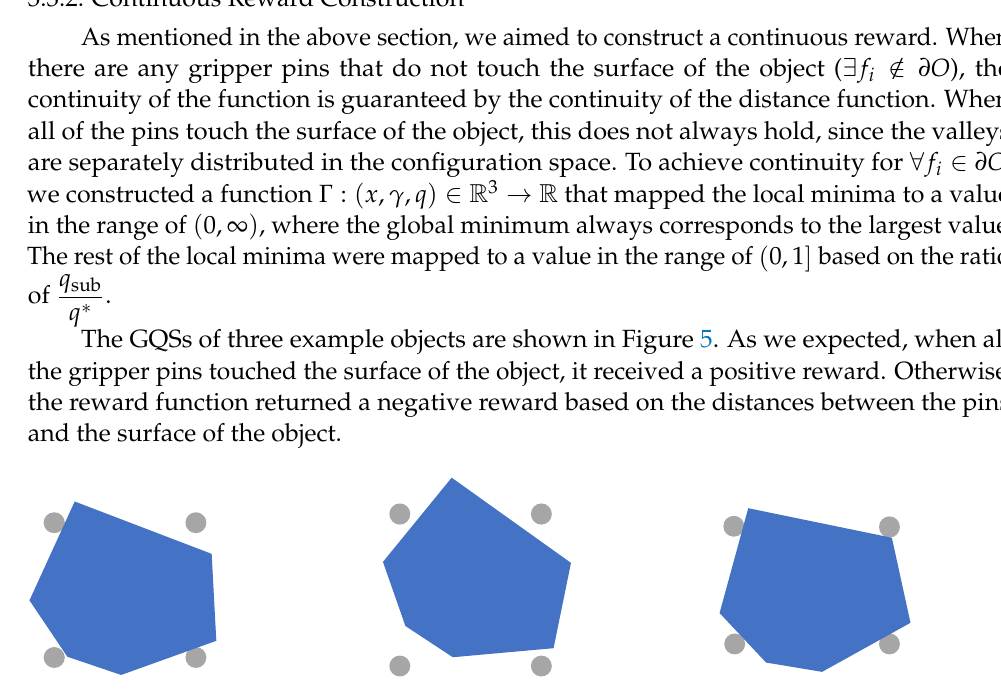
Figure 4. Illustration of the constraint region formed when the four-pin gripper grasps an object with a square cross-section.